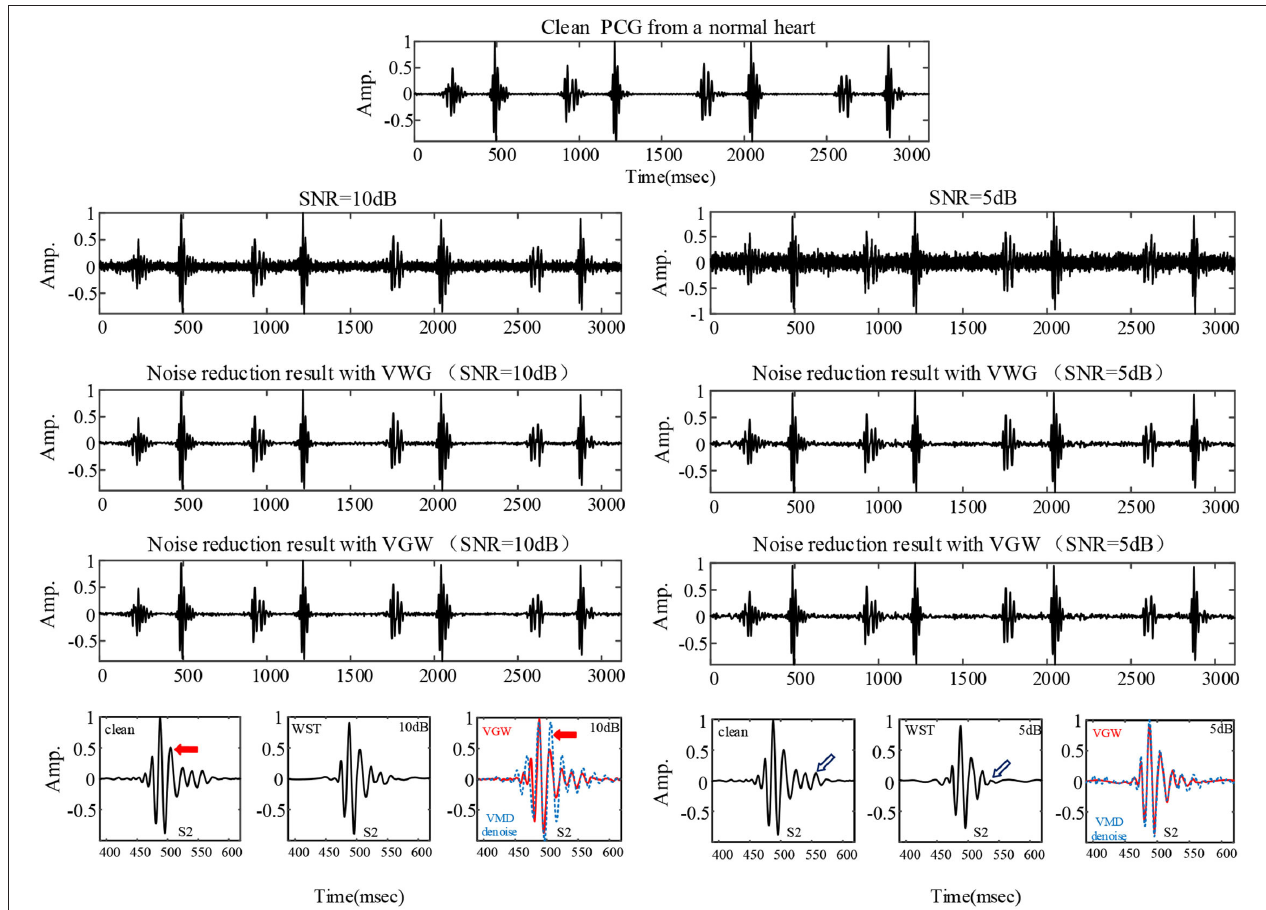
FIGURE 3 | The PCG of a healthy child collected professionally in a quiet environment and the denoising results for the PCG with 5 dB and 10 dB Gaussian noise added, respectively. The comparison of details is shown at the bottom: clean PCG and denoised PCG using the WST, VGW (red line), VMD-based method (blue line).